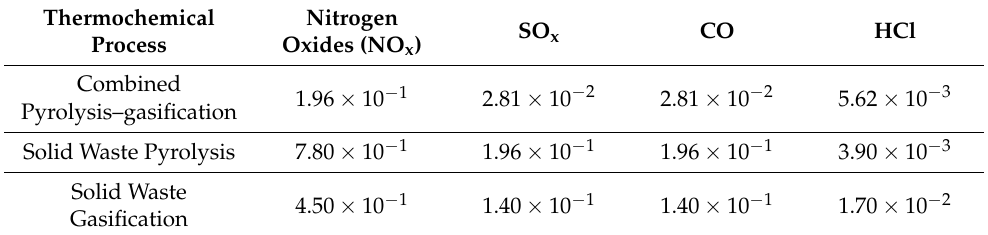
Table 1. Solid waste thermochemical reactions gaseous emissions (kg/tonne of product gas) [8,26–30].